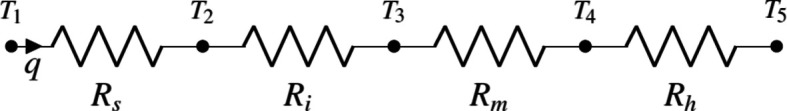
A simple one-dimensional thermal-resistor model of the mirror system. In this model q is the heat load and T
1 to T
5 are the temperatures at various locations in the mirror system. The maximum on the mirror surface is T
1, the minimum at the cooled end of the substrate is T
2, the substrate–manifold interface is T
3, the manifold–coolant interface is T
4 and the coolant bulk is T
5. The thermal resistances are: conduction in the mirror substrate R
s, contact resistance at the substrate–manifold interface R
i, conduction in the manifold R
m and convection to the coolant bulk temperature R
h.